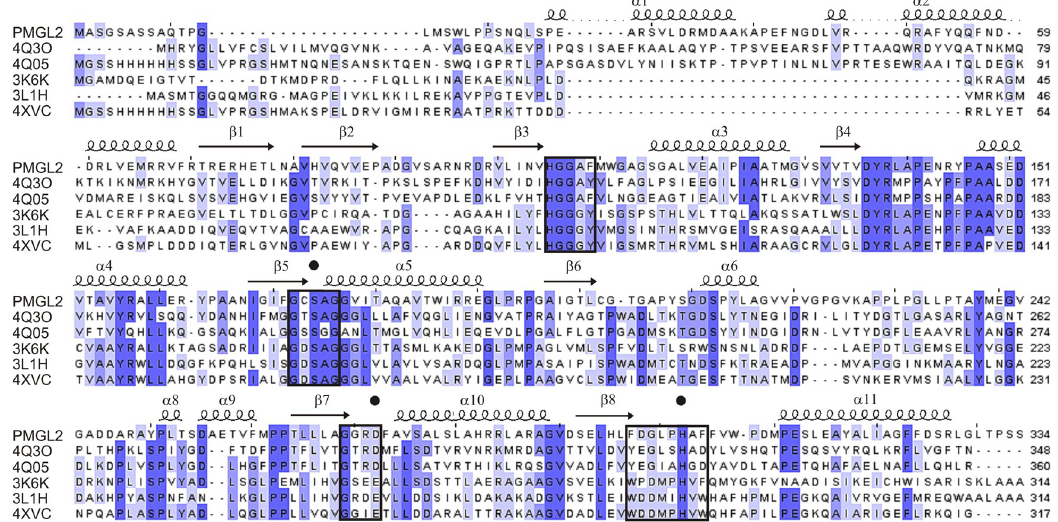
Fig 2. Multiple sequence alignment of PMGL2 and homologous enzymes with known three-dimensional structure. The extent of amino acid sequence conservation is depicted in grades of blue. PMGL2 secondary structure elements are indicated at the top. Black circles mark amino acid residues belonging to the catalytic